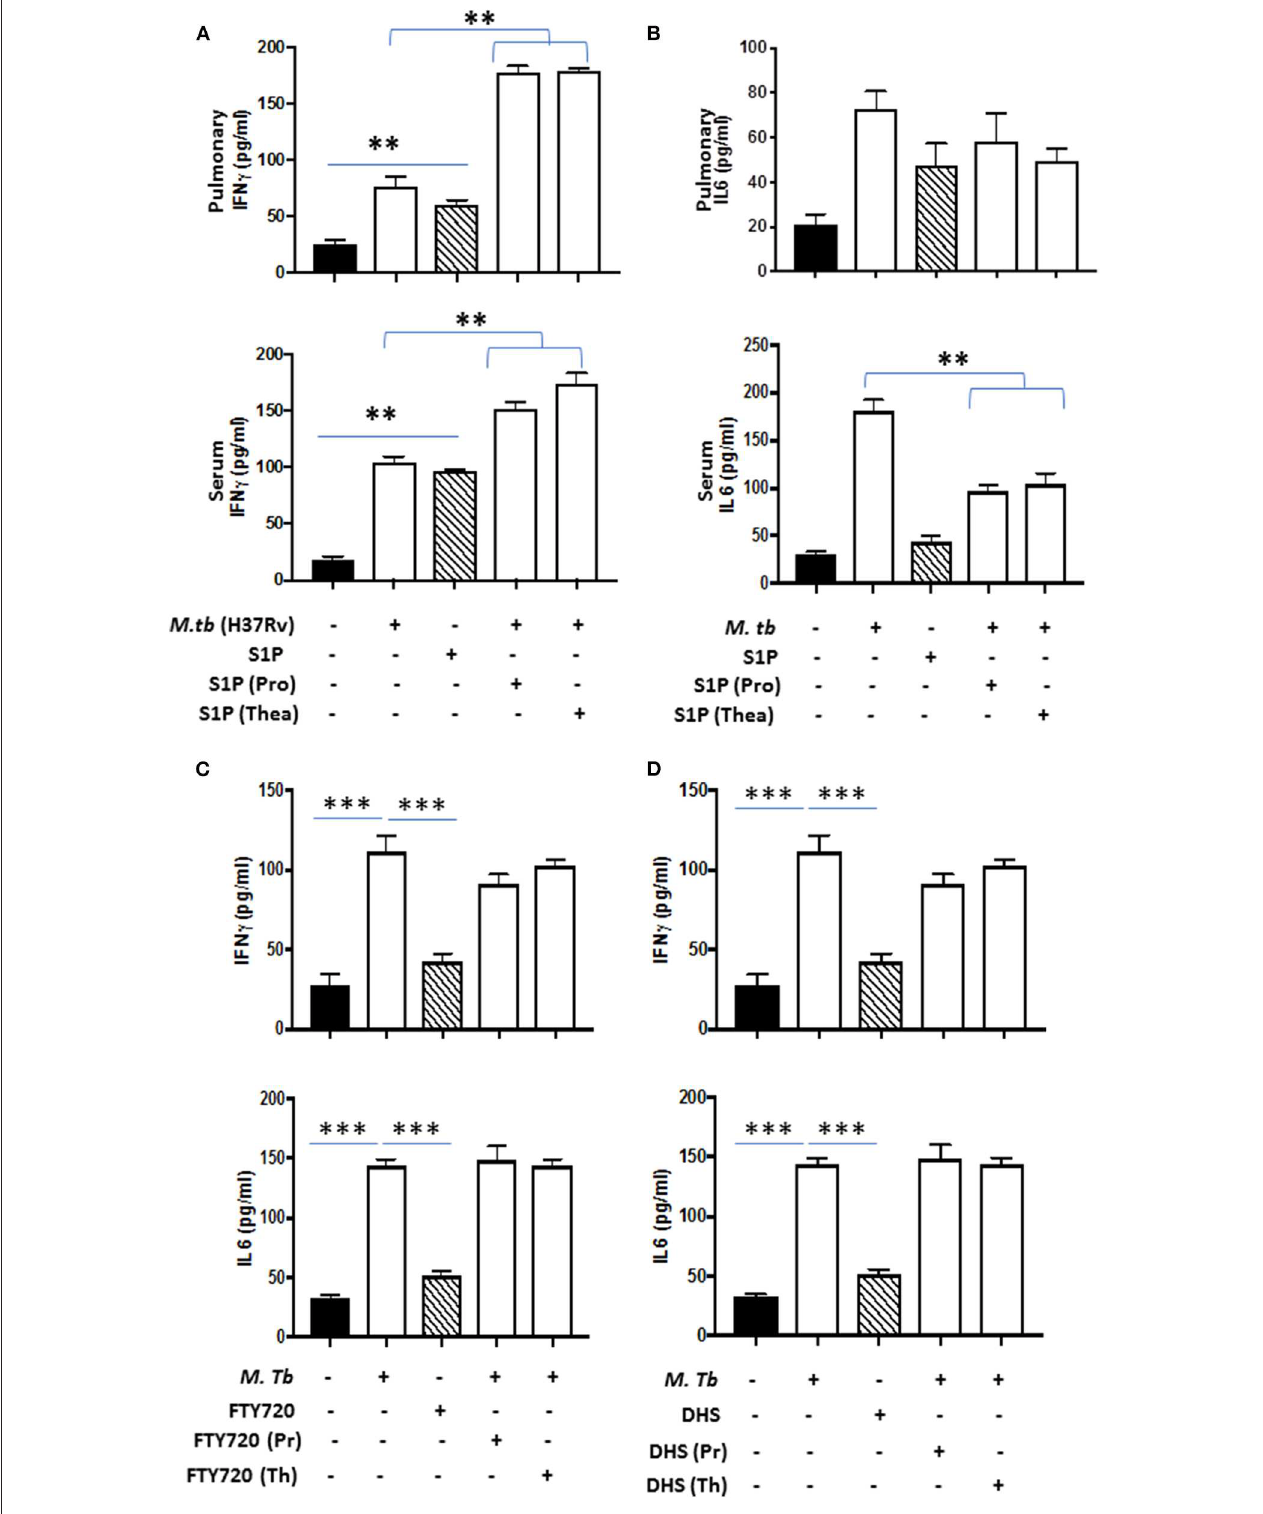
FIGURE 4 | Lung homogenates and serum were prepared from S-1P conditioned mice and IFN- γ ( A ; both pulmonary compartment and serum) and IL-6 ( B ; both pulmonary compartment and serum) titres were quantified by ELISA. Similarly, IFN- γ and IL-6 titres were quantified from lungs homogenates of mice treated with FTY720 (C) and DHS (D) by ELISA. Shown here is the pg/ml of cytokines produced ± SEM from several mice used in each group. Statistical analysis were conducted using two-way Anova followed by Bonferroni post-test (** P < 0.01, *** P < 0.001).